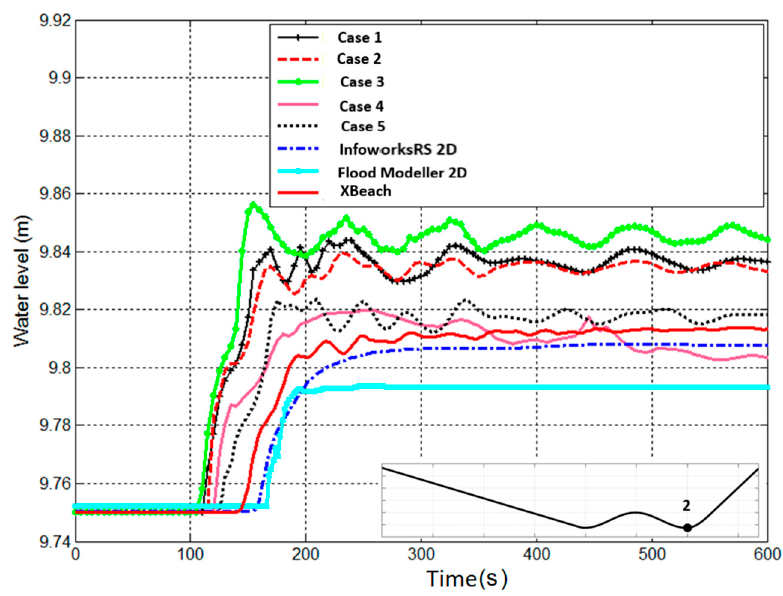
Figure 15. Momentum conservation over a bump: Point 2 water level results.